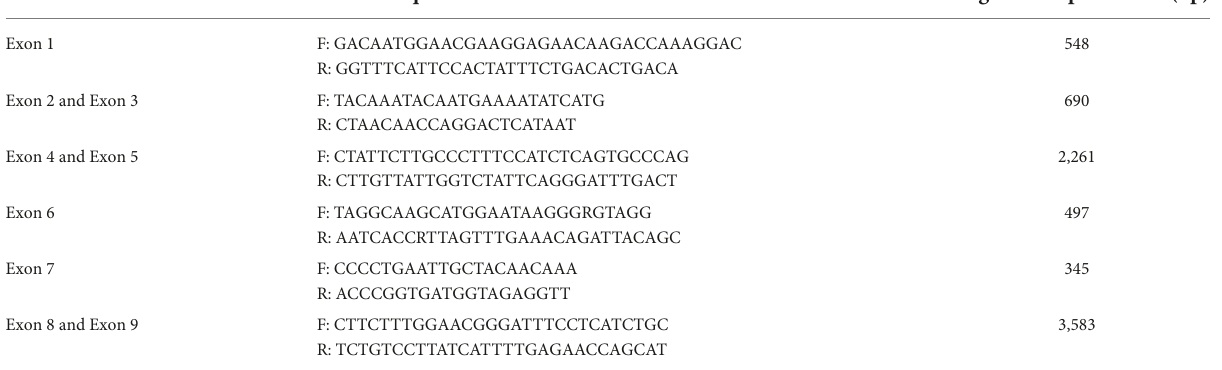
TABLE 1 Primers used for amplification and sequencing of CYP2C9 gene. Primer